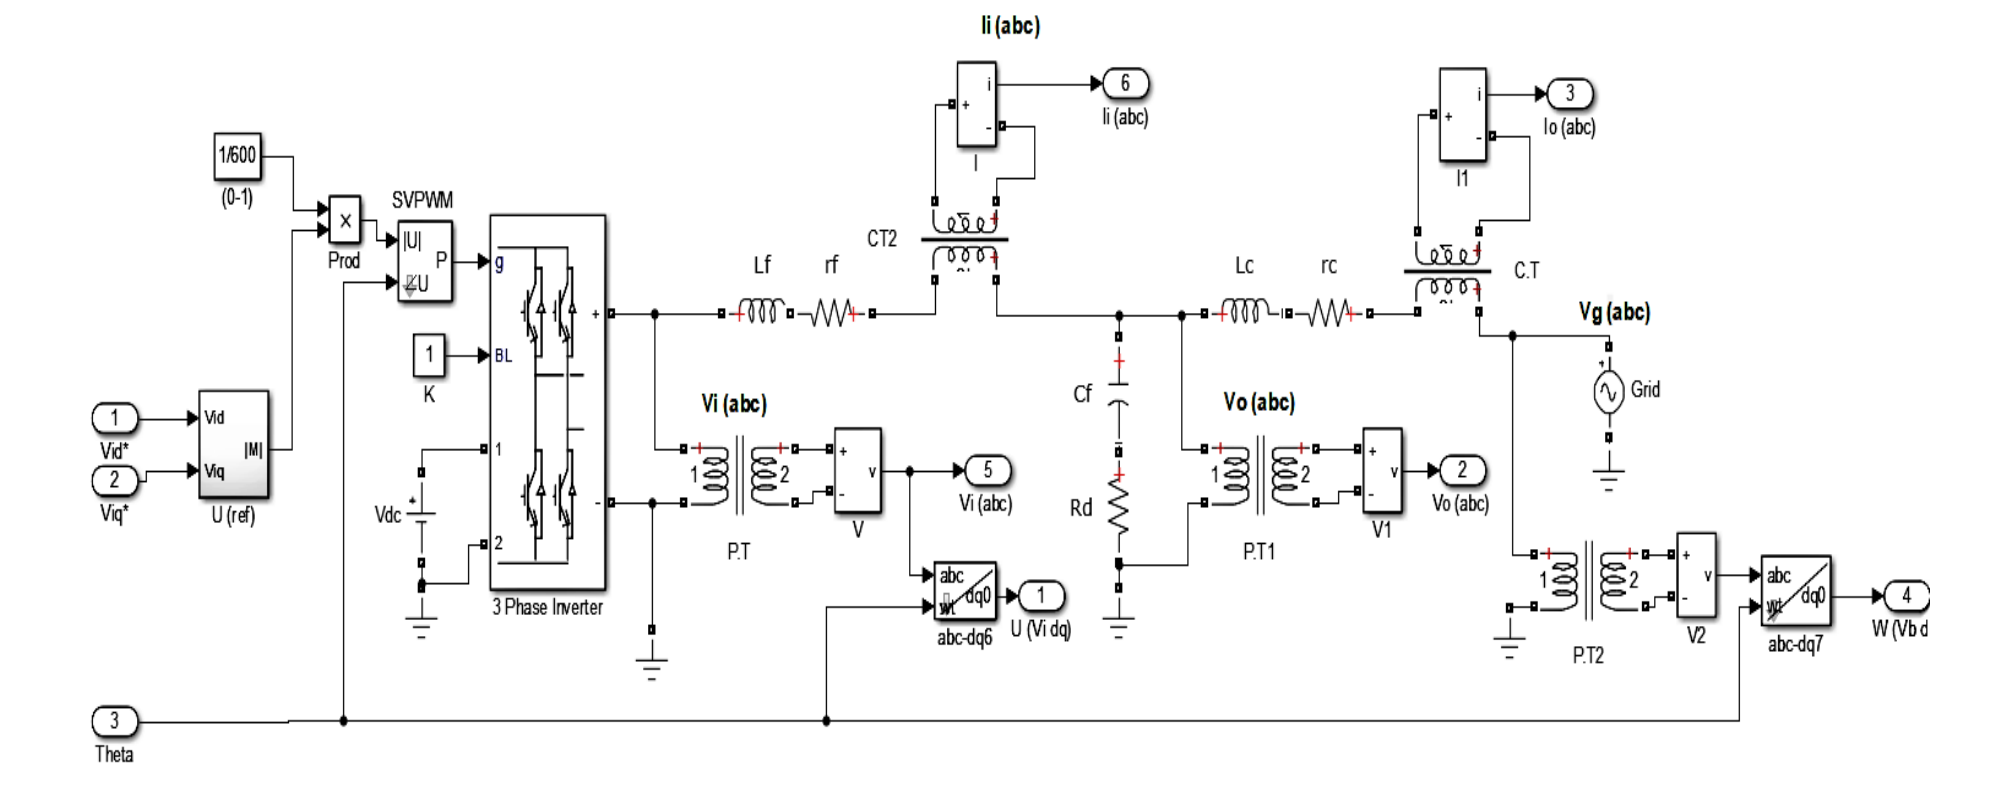
Figure 2. SLD of